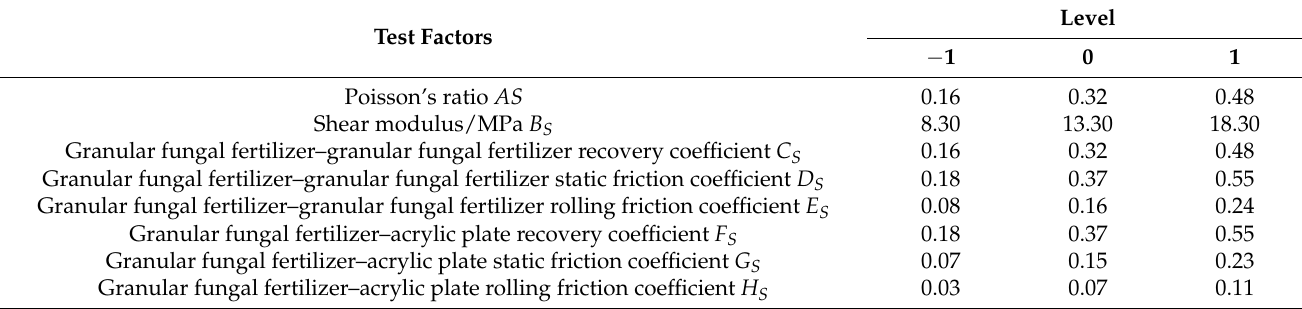
Table 5. Plackett–Burman test parameter range table.